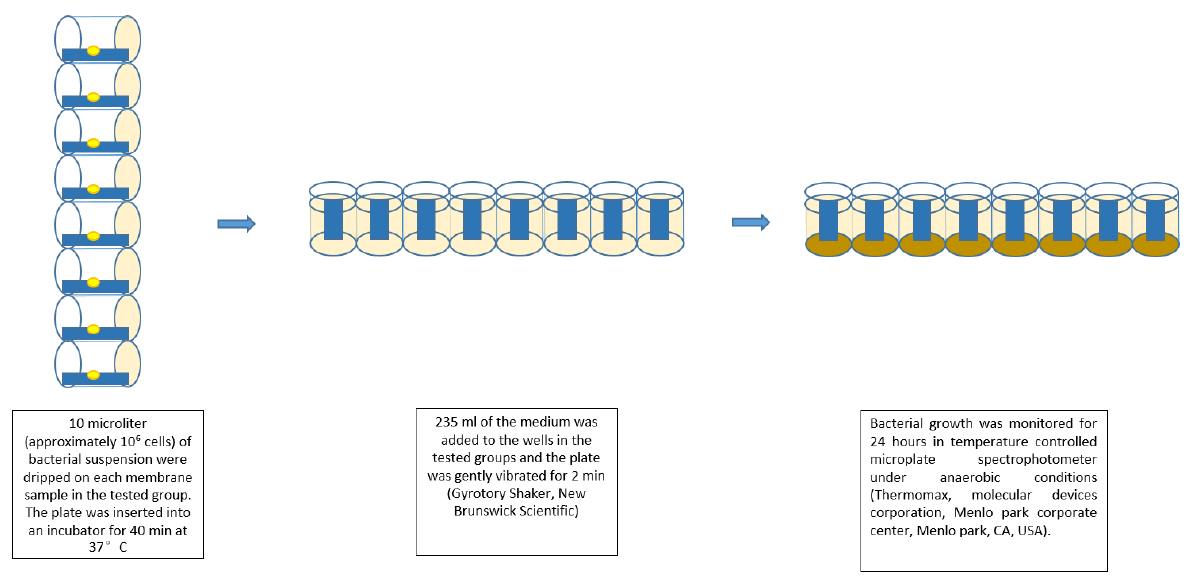
Figure 1. The study model workflow.